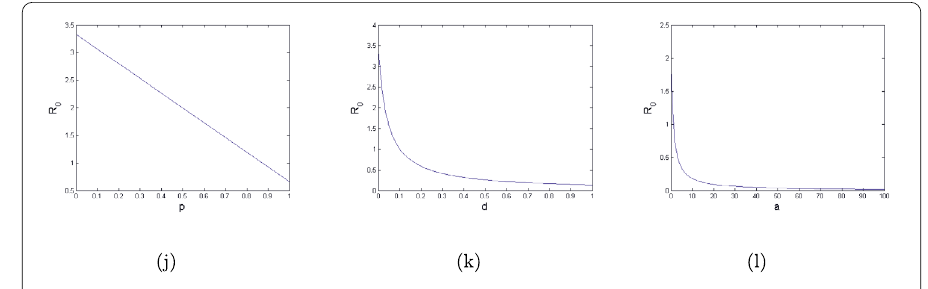
Figure 5 The behavior of R 0 in the special case (12) with the parameters: b = 10, μ = 0.04, β = 0.15, c = 0.5, γ = 0.003, d = 0.5, p = 0.8, (cid:4) = 0.2, and a = 0.3 for ( j ) and the same parameters except b = 20 for ( k ) and ( l )